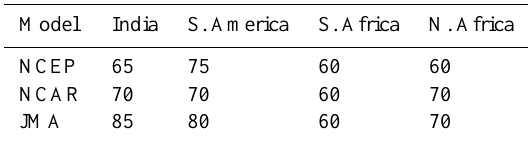
Table 1. Value of constant c in different regions in different